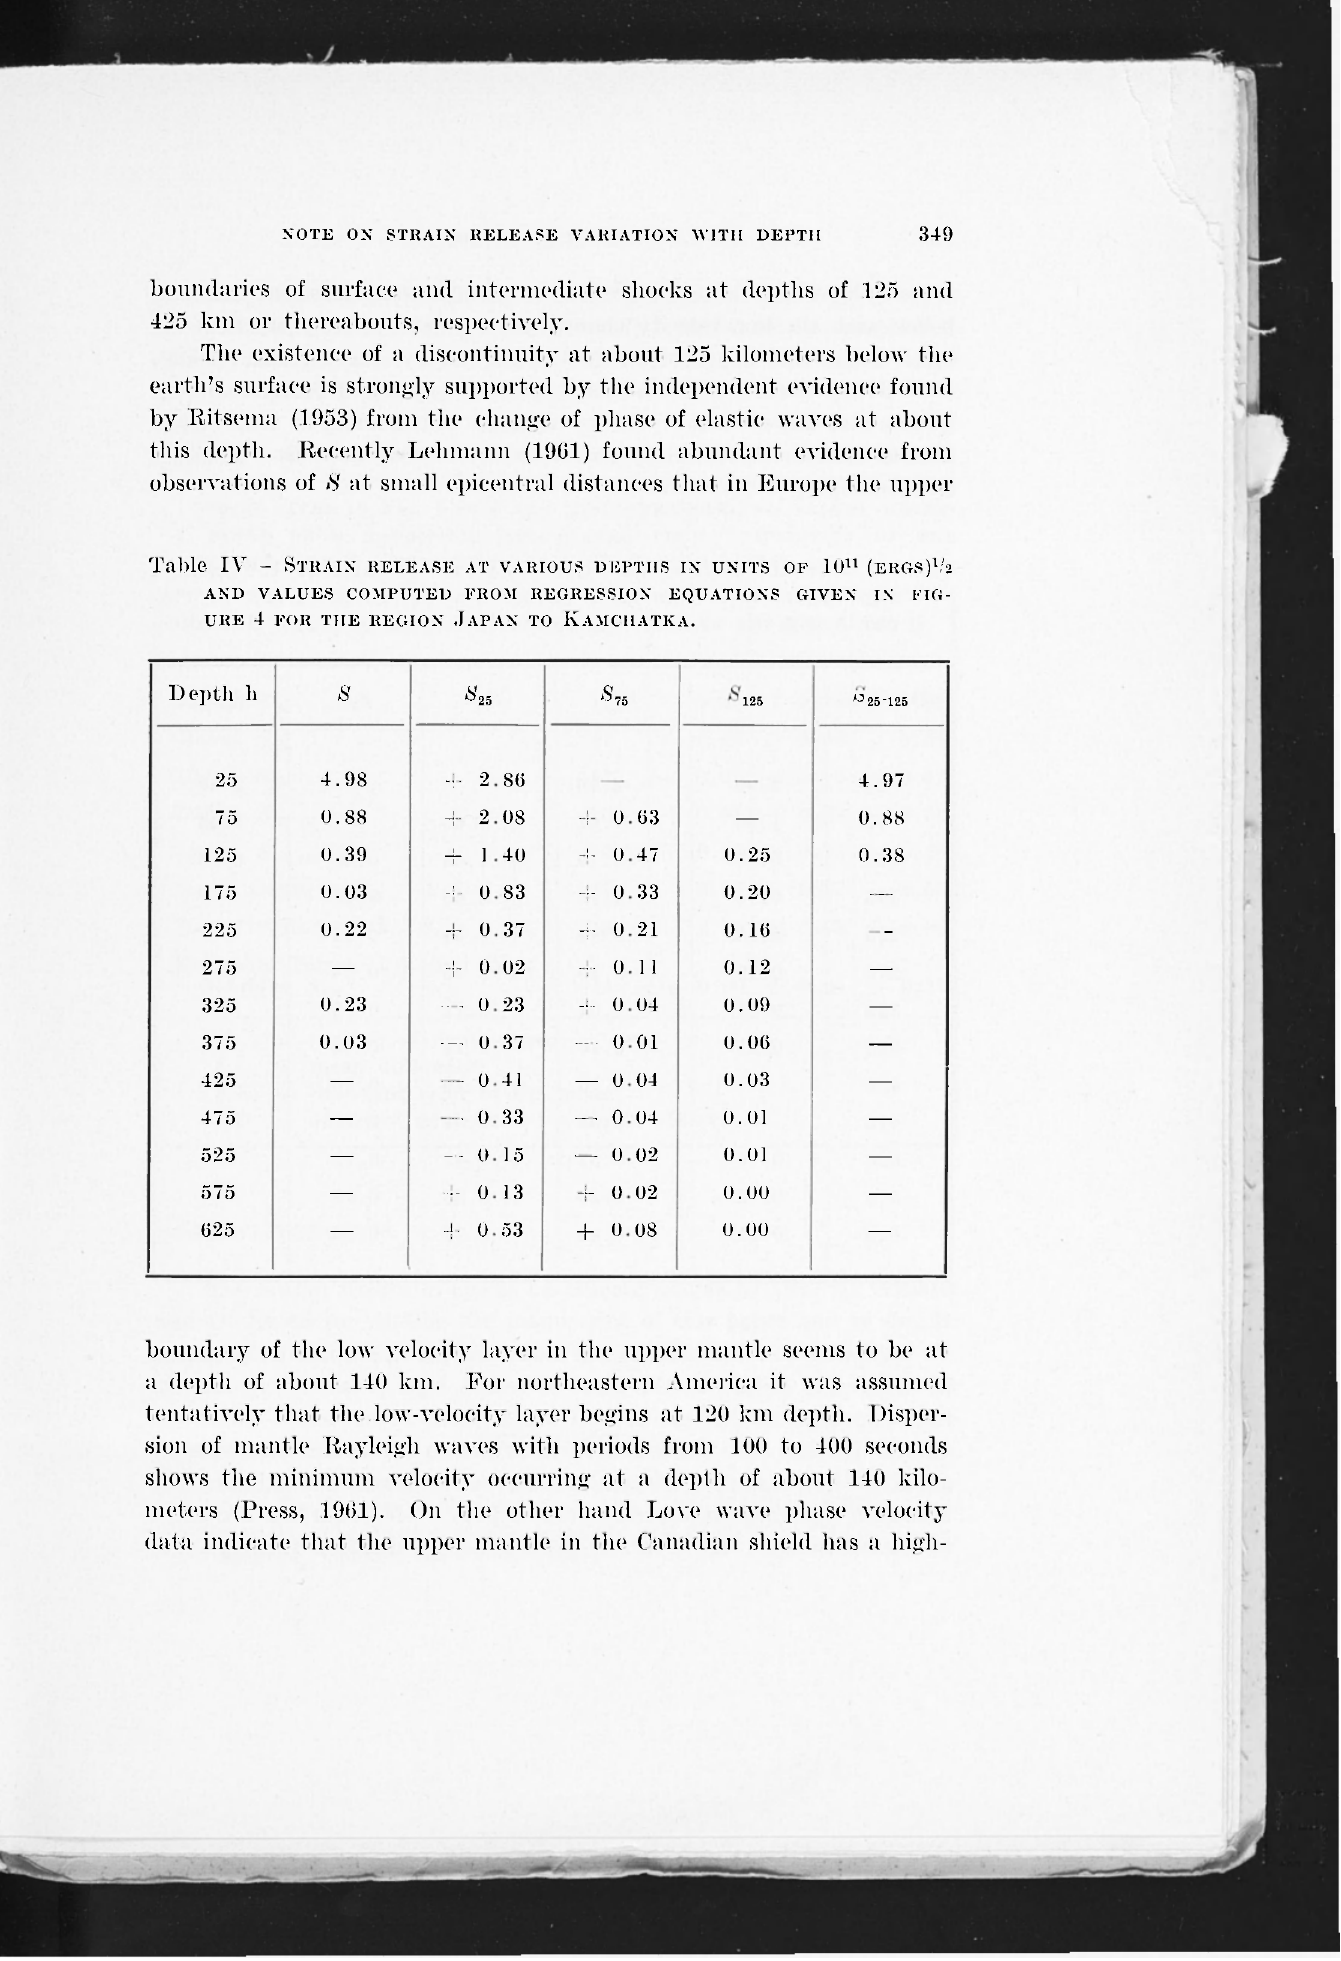
URE 4 FOR THE REGION JAPAN TO